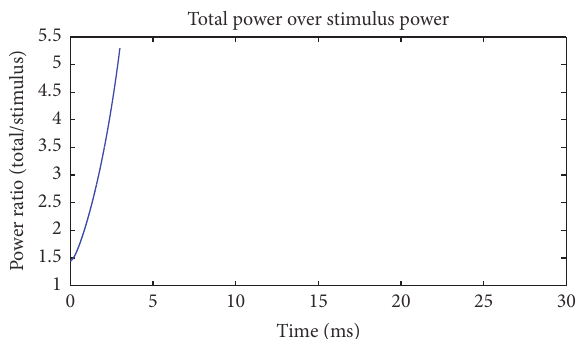
Figure 17: Ratio of total power and stimulus power